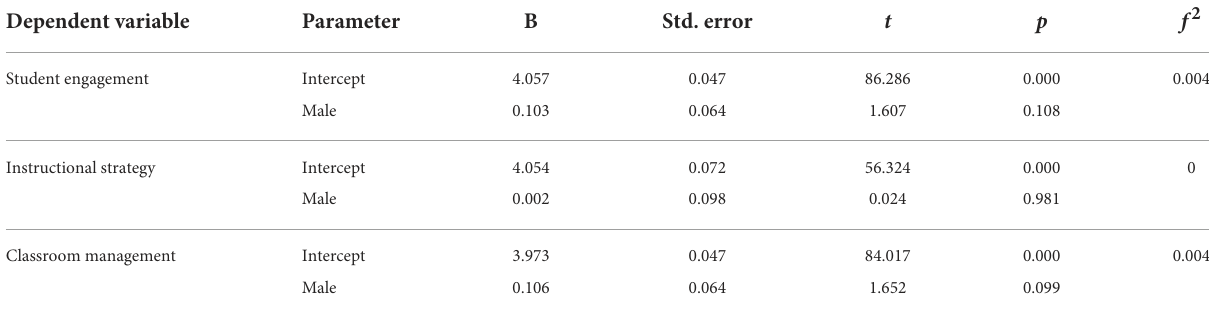
TABLE 3 Regression parameters of the influence of gender on teachers’ sense of teaching self-efficacy beliefs in SBC implementation. Dependent variable